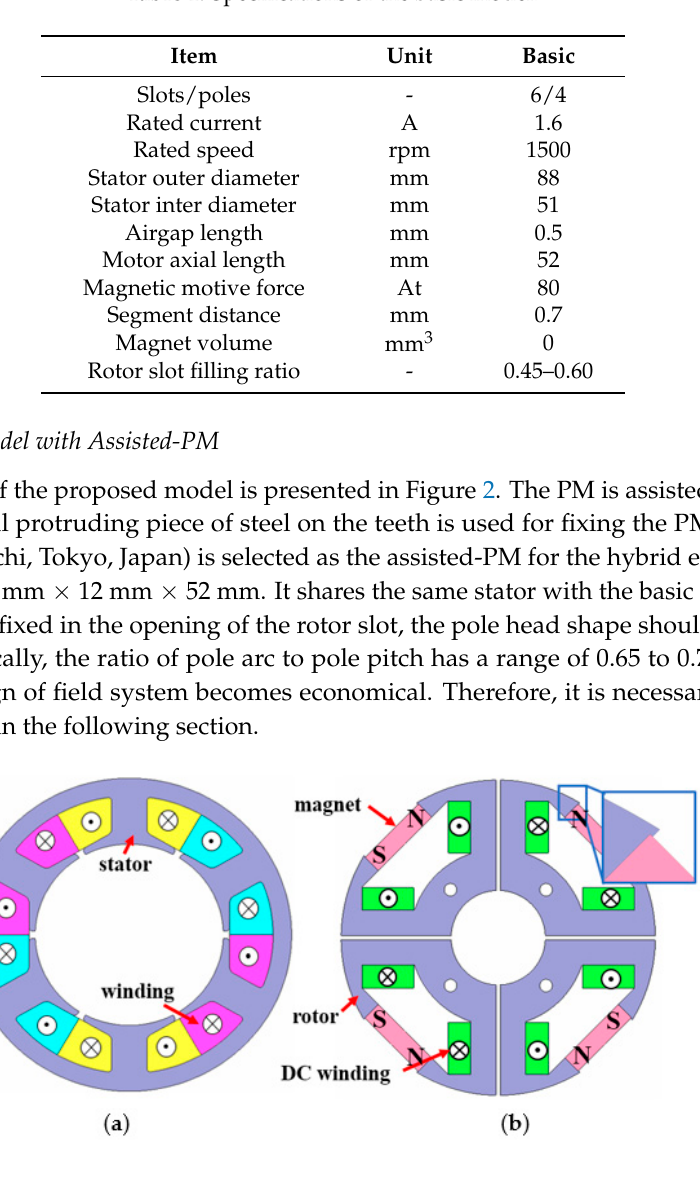
Figure 2. Topology of the proposed model: ( a ) Stator; ( b ) Proposed rotor.